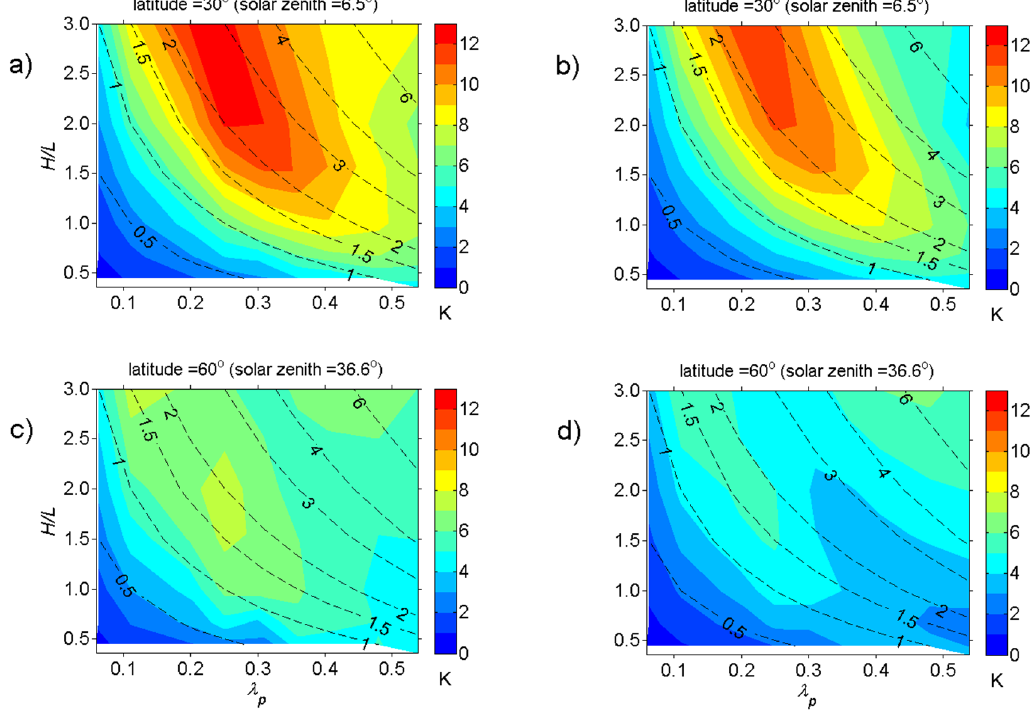
Figure 6. Maximum anisotropy ( left ) and maximum difference from nadir ( right ) as a function of geometric ratios H/L and λ P , for 1200 LST 21 June at latitudes 30° ( a , b ) and 60° ( c , d ). Values are averaged over all street orientations. Dashed, numbered lines are building height to street width ratios ( H/W ).